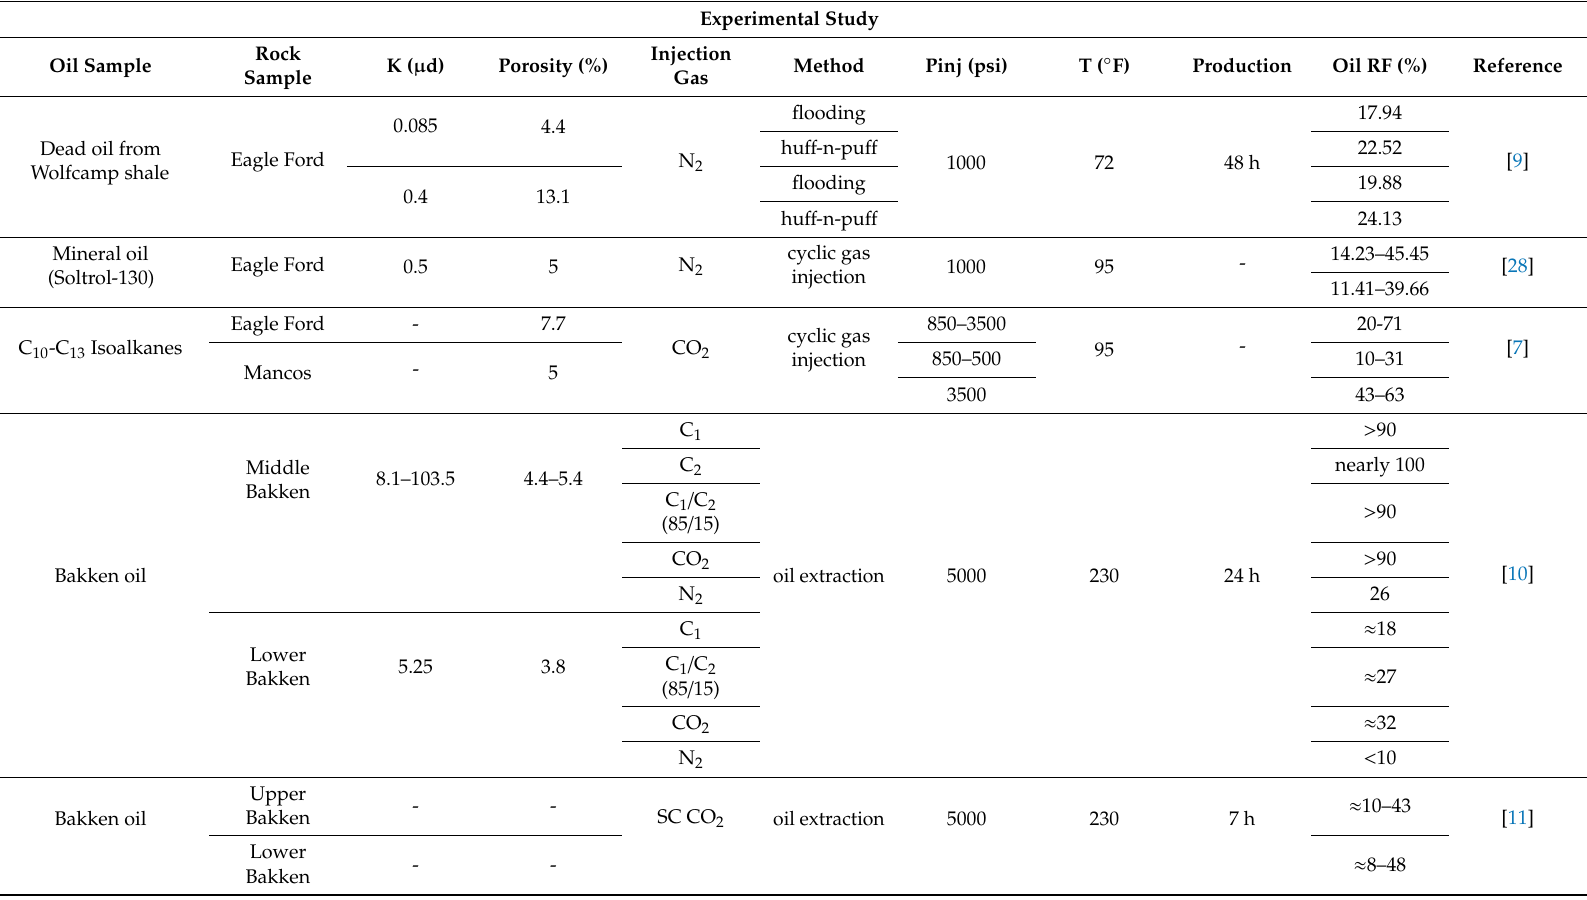
Table 1. The experimental studies about di ff erent gas injection approaches in shale reservoirs for